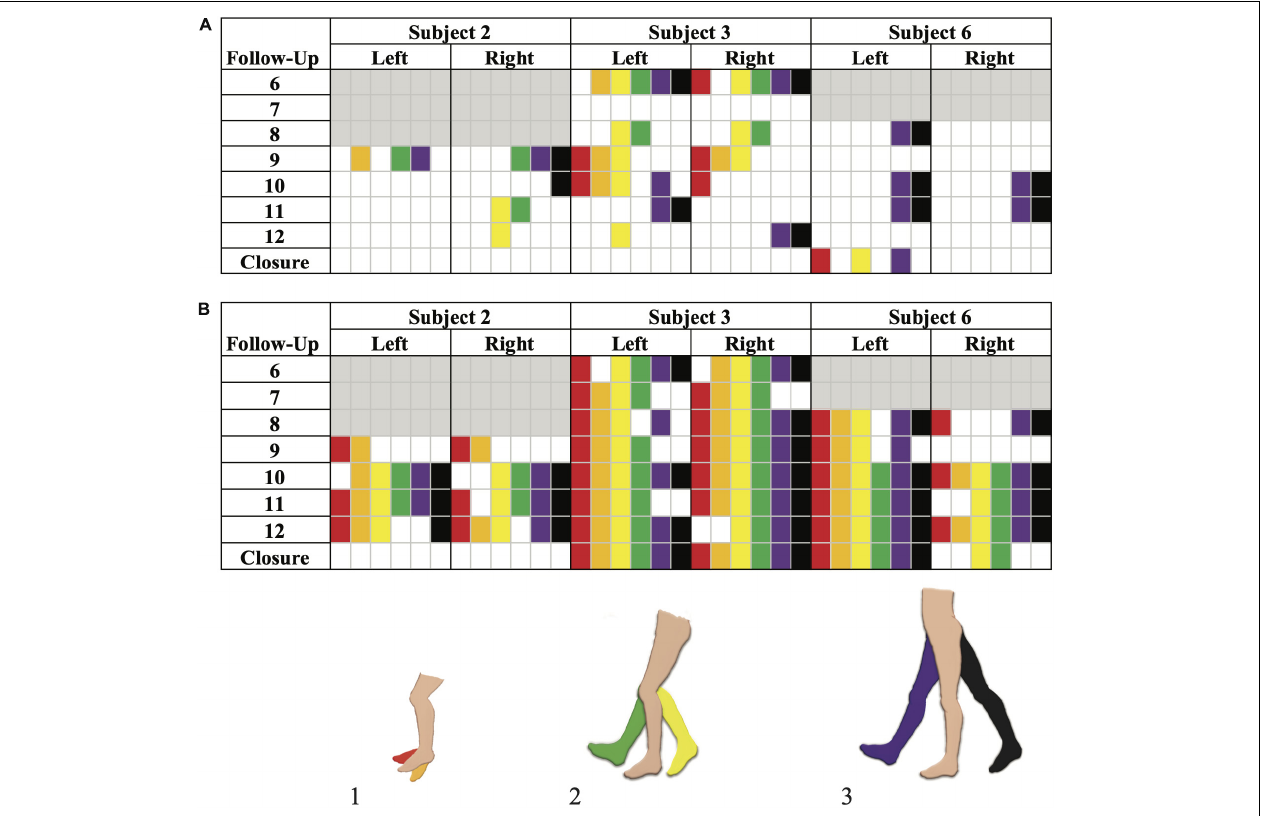
FIGURE 4 | Brain Motor Control Assessment (BMCA) documented muscle activation without stimulation (A) and with stimulation (B) in the SVM group. Joint movements are color coded as follows: (1) red, ankle dorsiflexion and orange, ankle plantarflexion. (2) Yellow, knee flexion and green, knee extension. (3) Purple, hip flexion and black, hip extension. Follow-up visits 1–5 and Subject 5 are not included as the BMCA CRF had not been implemented yet. Each subject’s introduction of the CRF form is color-coded by gray boxes. Movements observed prior to the implementation of the BMCA CRF have not been included here. Recorded movements only occurred during the volitional task windows of the BMCA (A) . Recorded movements during BMCA in the absence of stimulation . Subject 3 demonstrated persistent movement in the absence of stimulation the earliest and across the most muscle groups among the SVM group. (B) Recorded movements during BMCA with stimulation on are included in order to exemplify how movement with stimulation is more prevalent earlier on in the study and across more muscle groups than movement without stimulation.